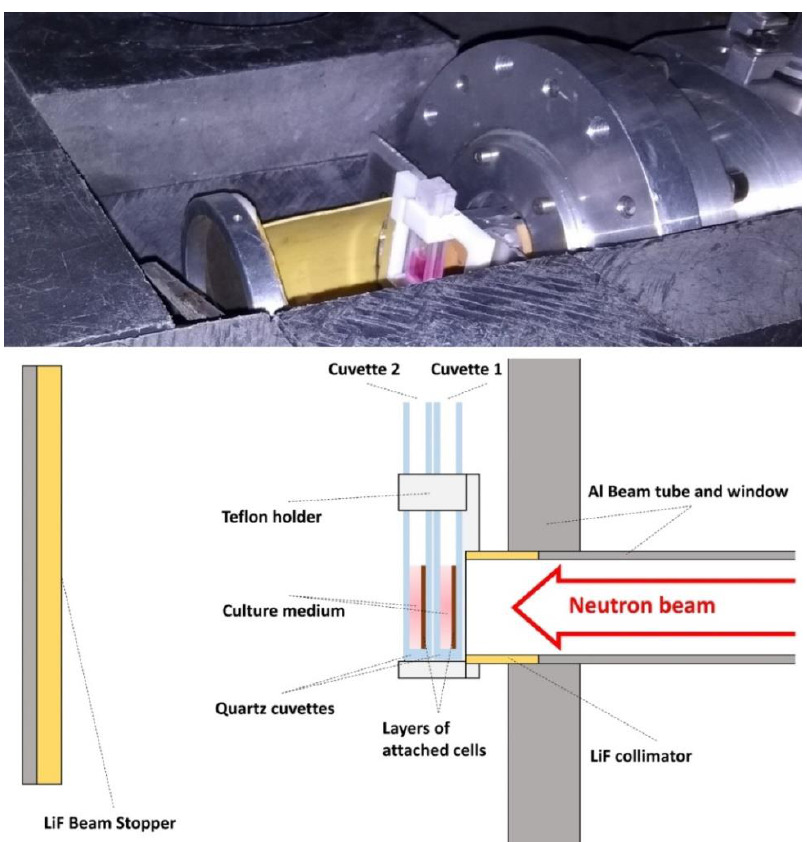
Figure 2. Picture and schematic cut view of the experimental arrangement installed on the PF1B instrument at the institute Laue-Langevin (ILL). Two cuvettes containing cells were irradiated at the same time. All of the cells are irradiated homogeneously and the second cuvette receives a smaller dose than the first one. LiF is used as the first layer of collimators and as a beam stop, capturing neutrons without the generation of secondary gamma radiation.